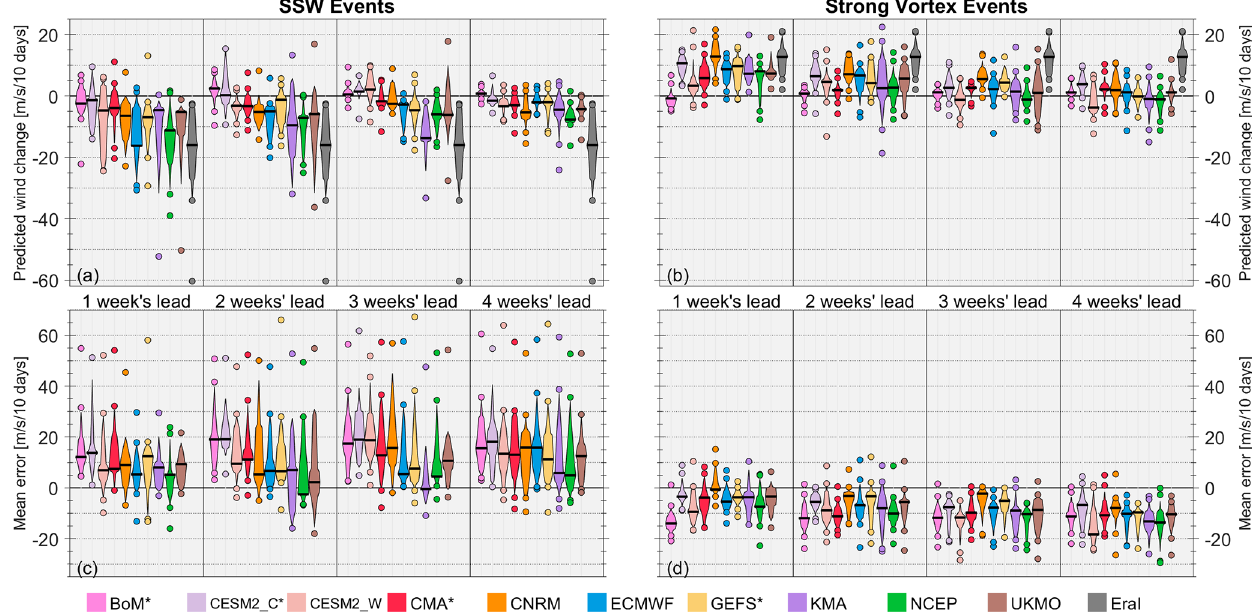
Figure 7. Distributions of the composited wind changes forecasted by each ensemble for forecast verification times surrounding (a, c) boreal sudden stratospheric warmings and (b, d) strong vortex events, composited over all such events in the 1999–2010 hindcast records. This corresponds to 11 SSW events and 13 strong vortex events across the boreal winters from 1999/2000 to 2009/10. Units are ms − 1 over the 10d period centered on the observed event central dates within the forecasts or reanalysis. Within each section of each panel, data are shown as violin plots covering the 15%–85% range of wind changes or mean errors, with outliers outside this range indicated with individual colored circles and horizontal black lines indicating the median value. In panels (a) and (b) the quantities shown are raw values, while those in panels (c) and (d) are shown as deviations from ERA-I (EraI in the figure). Note that individual models may contain a slightly different number of samples, especially for longer lead times, due to the different hindcast lengths available for each system (see Table 1); in other words, some hindcasts do not fully cover the 10d periods surrounding the observed SSWs and strong vortex events and are excluded.